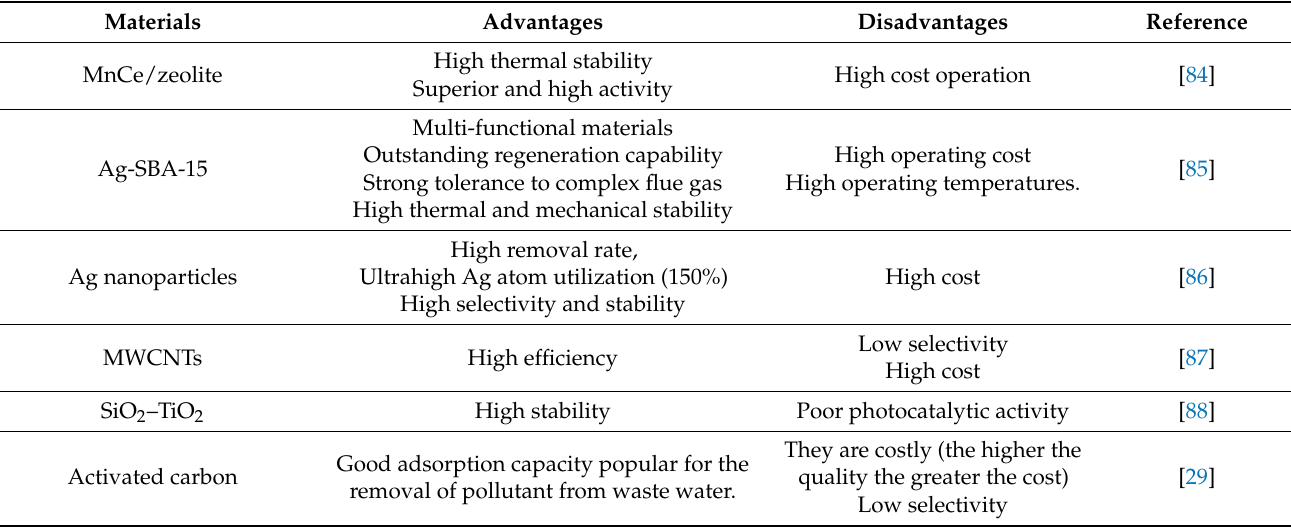
Table 2. Properties comparison of different adsorbents for mercury